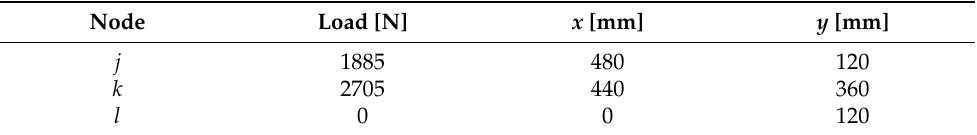
Table 1. Optimized concentrated loads and their locations on the idealized spoiler demonstrator according to Equation